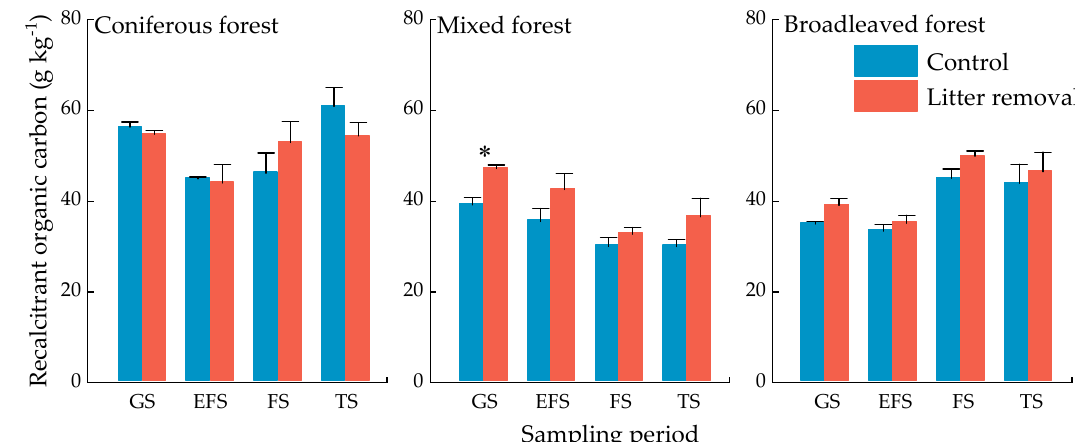
Figure 7. Concentrations of soil recalcitrant organic C pool of three forests at different sampling periods. Values indicate means ± standard error, n = 3. GS: growing season, EFS: early freezing season, FS: freezing season, TS: thawing season. Asterisks indicate significant differences between the two treatments in same forest type at the same season. * p < 0.05.